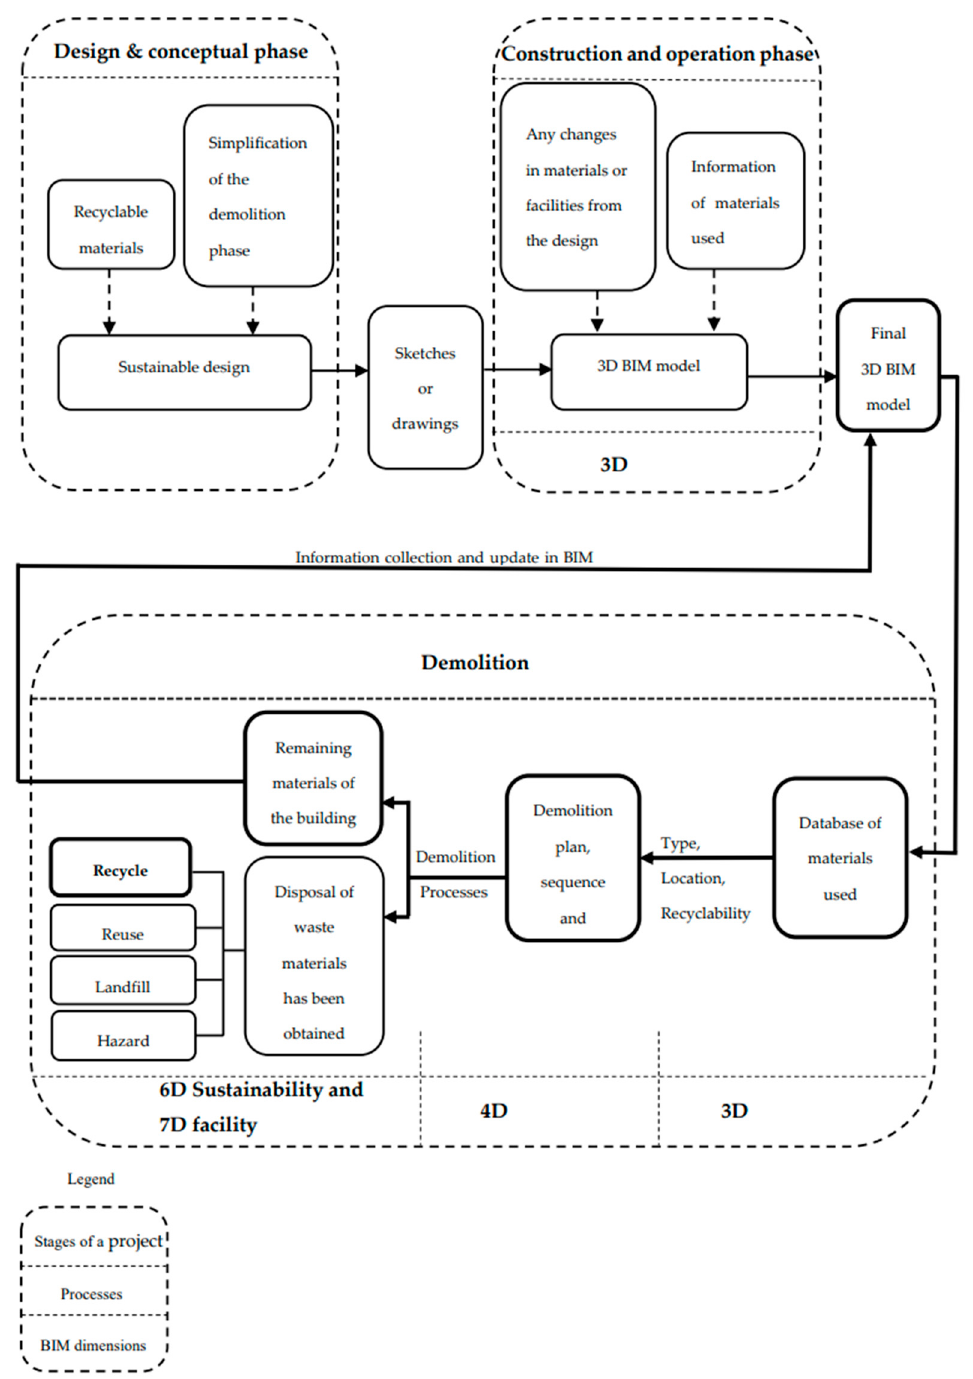
Figure 6. The developed recycling and demolition